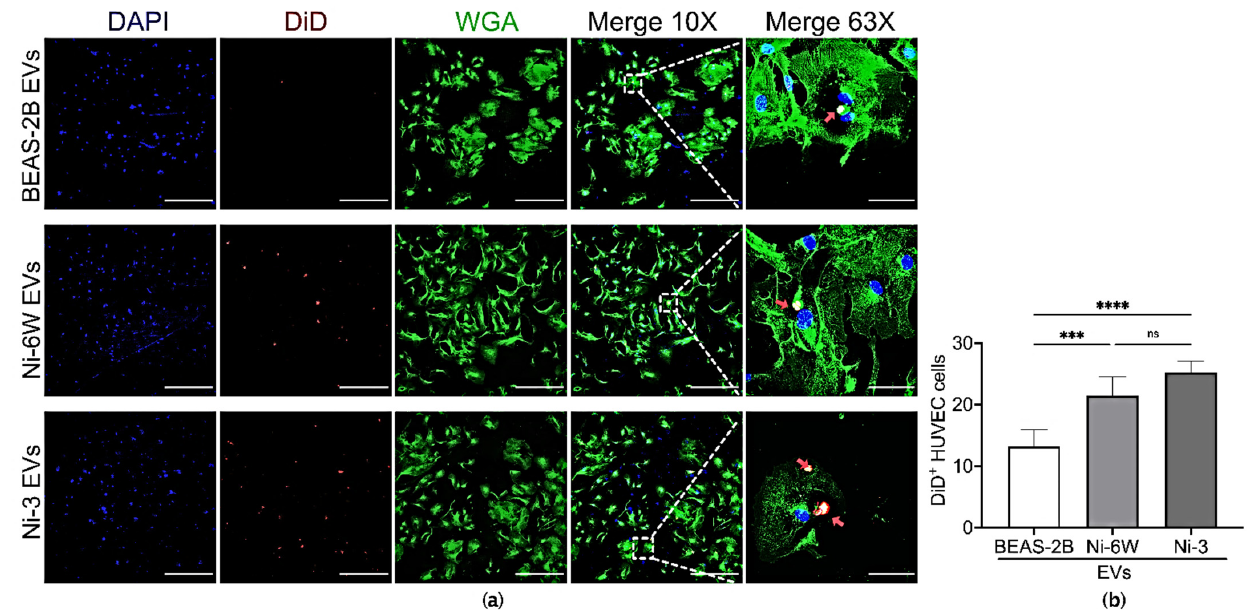
Figure 4. Ni exposure affected the incorporation of BEAS − 2B − derived EVs in HUVEC cells. ( a ) EVs from BEAS − 2B, Ni − 6W, and Ni − 3 were isolated, labelled with DiD dye, and added to HUVEC cells for 5 h before being scanned with a confocal microscope (scale bar: 400 µm (10×) and 60 µm (63×), Zeiss 880). Blue—DAPI, red—DiD, green—WGA, red arrow—incorporated EVs. ( b )